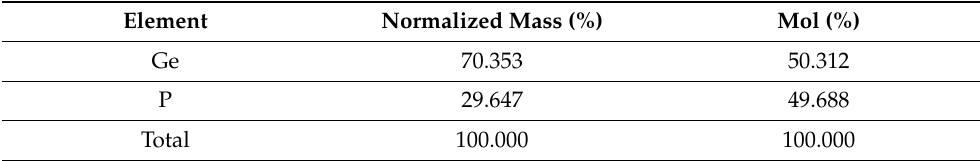
Table 1. The elemental contents of Ge and P.